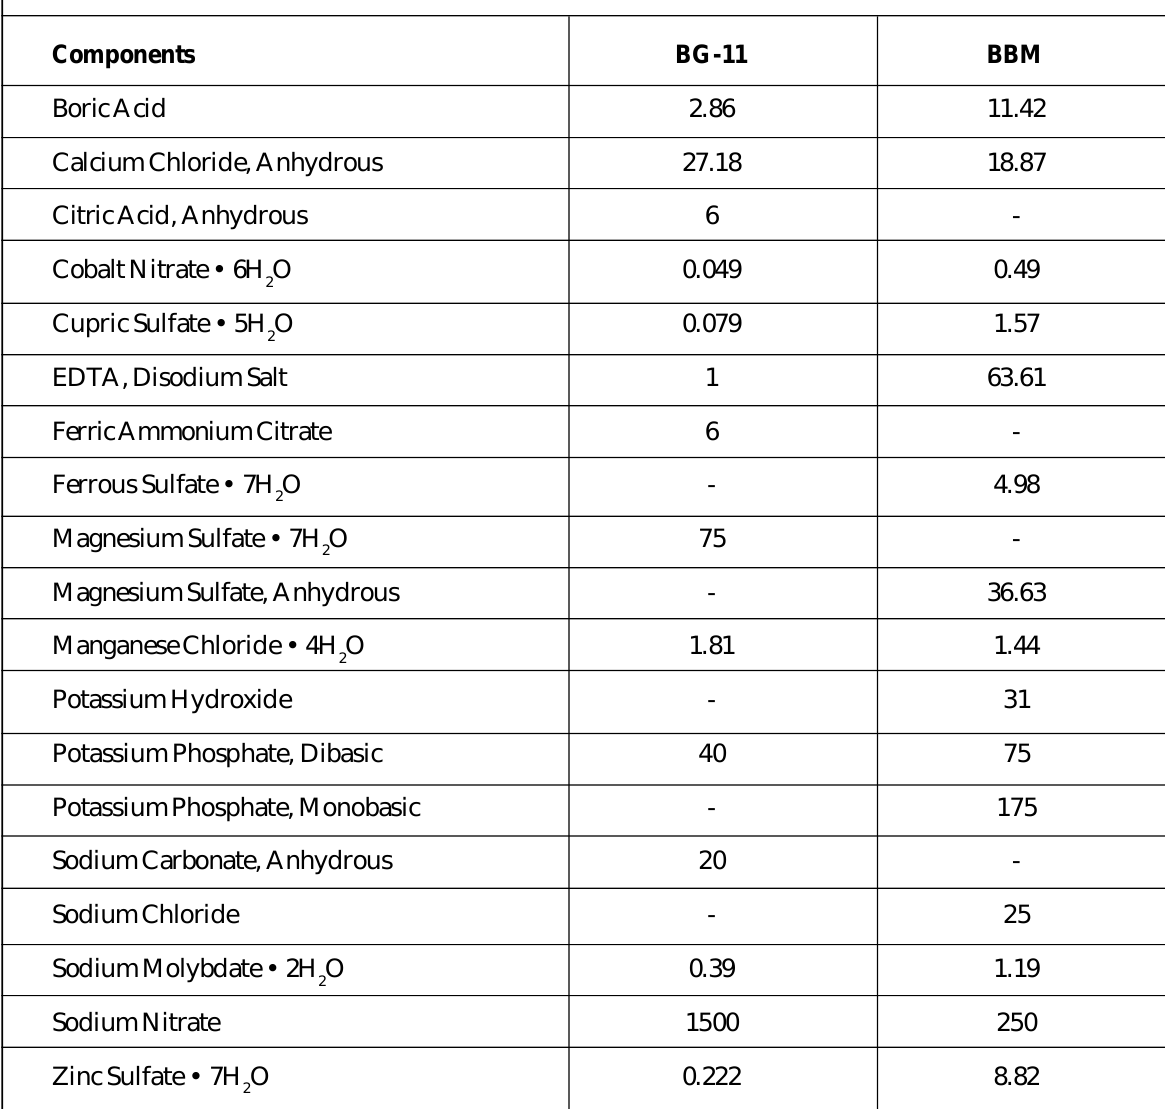
Table 1: Chemical composition of the BG-11 and BBM media used for microalgae population growth. The concentration of salts in mg L